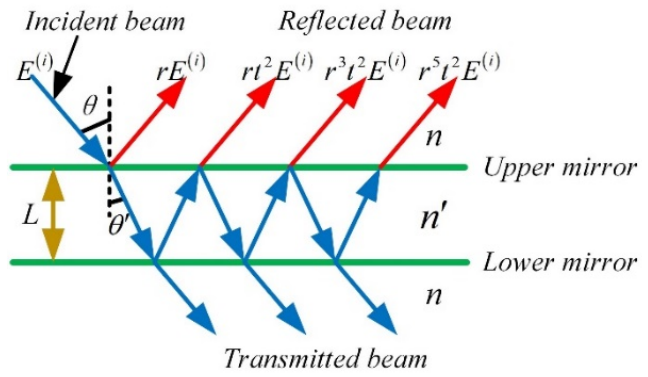
Figure 4. Schematic diagram of multi-beam interference in plate.